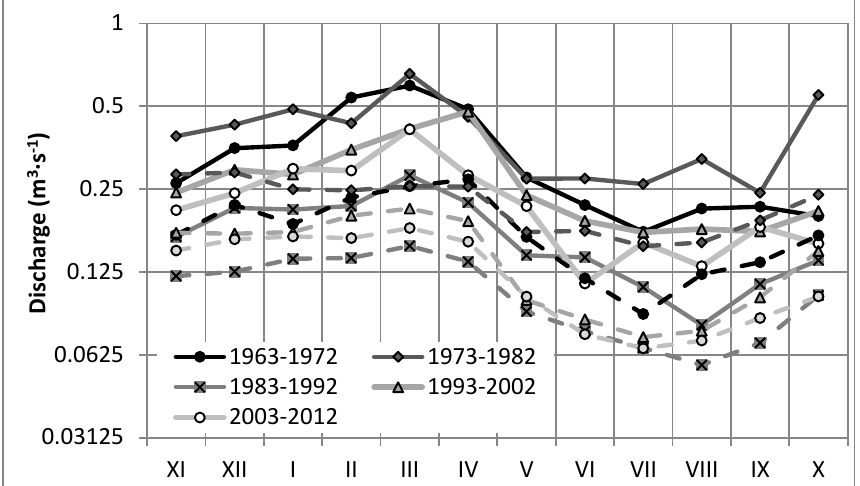
Figure 8. Average monthly (solid lines) and minimum average discharge (dashed lines) in selected decades.